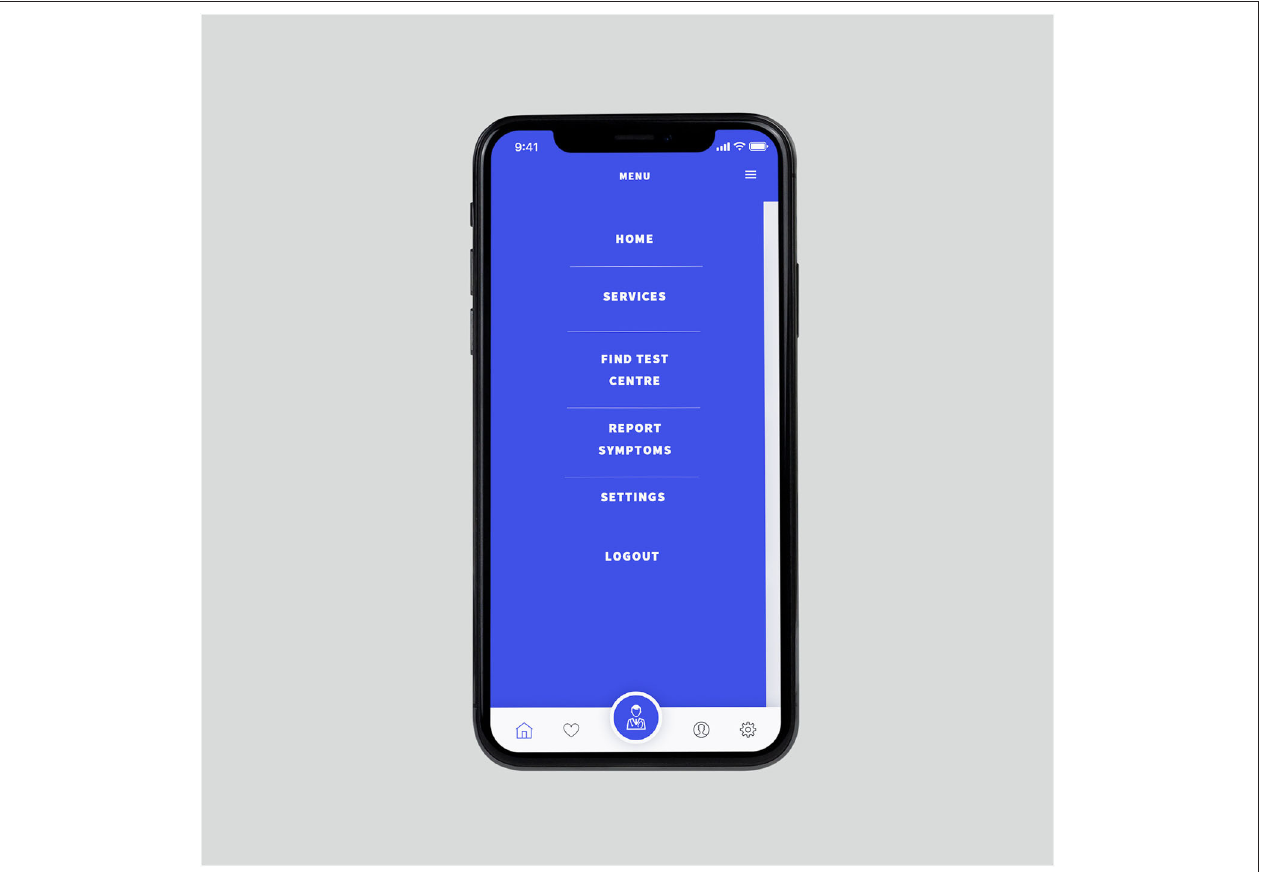
FIGURE 7 | The navigation panel. (From Left) Using the icons at the bottom of the screen, users can also navigate to the home page, access their favorite news articles, visit the services page, access their profile, and application settings. into the MLA to evaluate the information and find the best possible